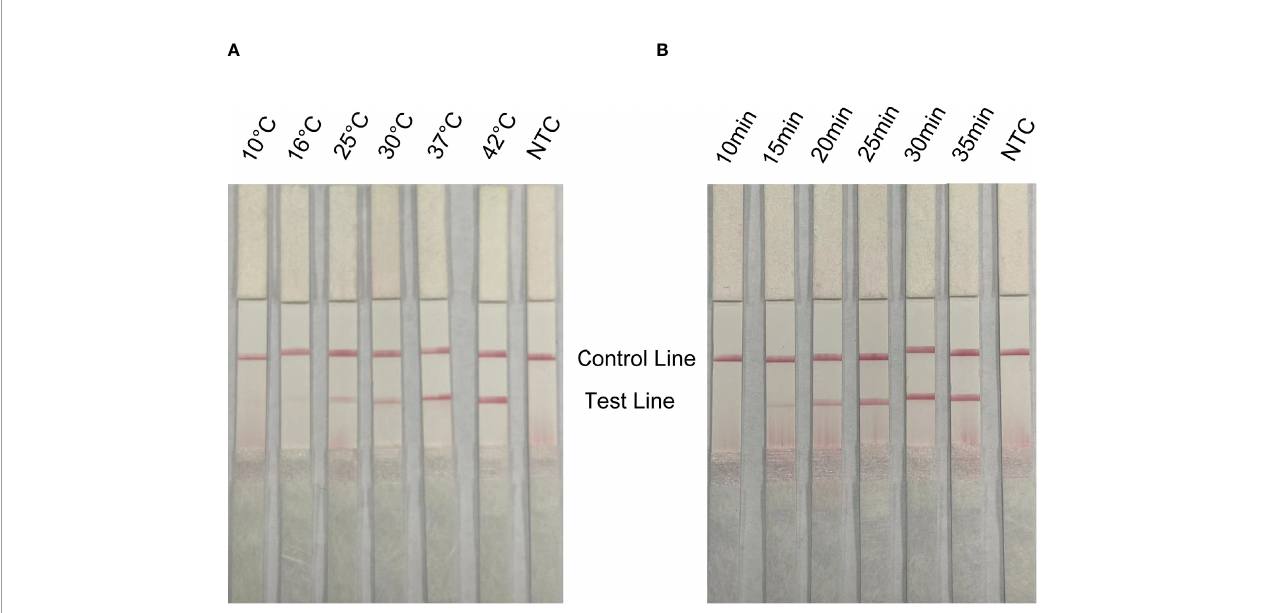
FIGURE 5 | Optimization of reaction conditions for RPA-LFS; 1 µl of 2 × 10 9 copies/ml was used as the template for the reaction. (A) The RPA-LFS test was performed at different reaction temperatures ranging from 10°C to 42°C. (B) The RPA-LFS tests were carried out at different reaction times ranging from 10 to 35 min. NTC was a template-free negative control. The time and temperature of the reaction are shown at the top of the strip,